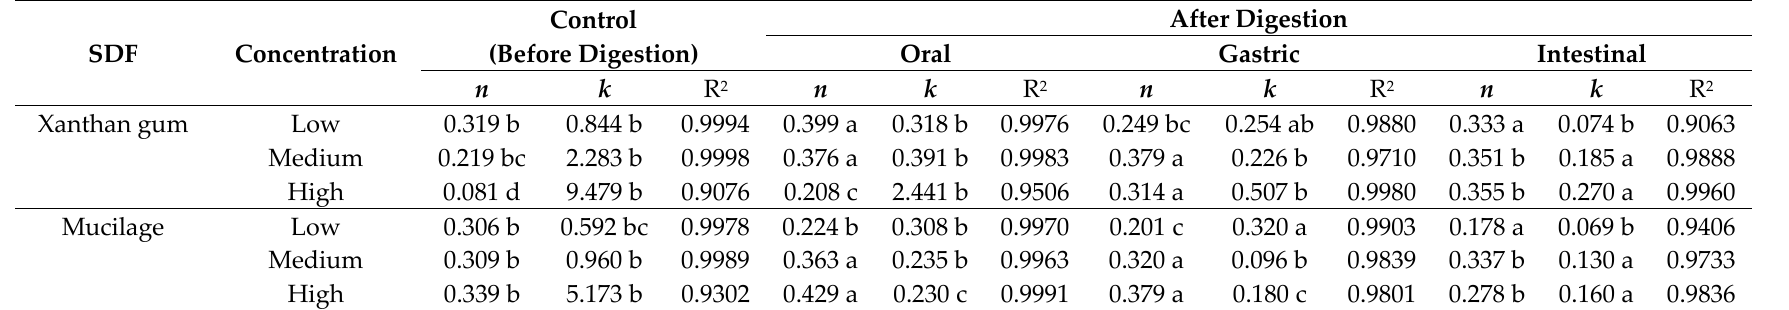
Table 1. Power of Law parameters for xanthan gum and mucilage from chia seed during in vitro